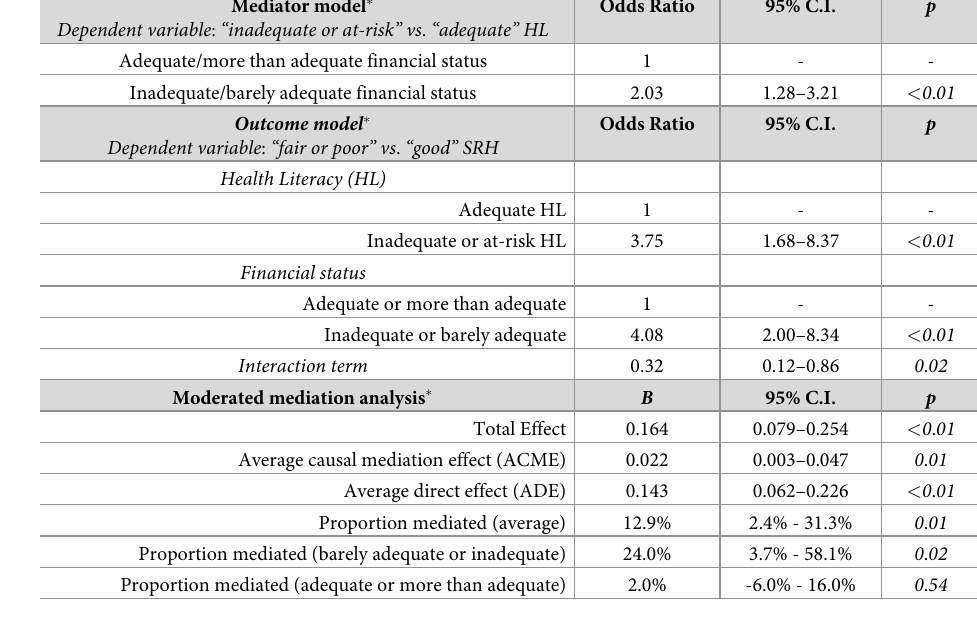
Table 3. Mediator model, outcome model and moderated mediation analysis for financial status. Mediator model